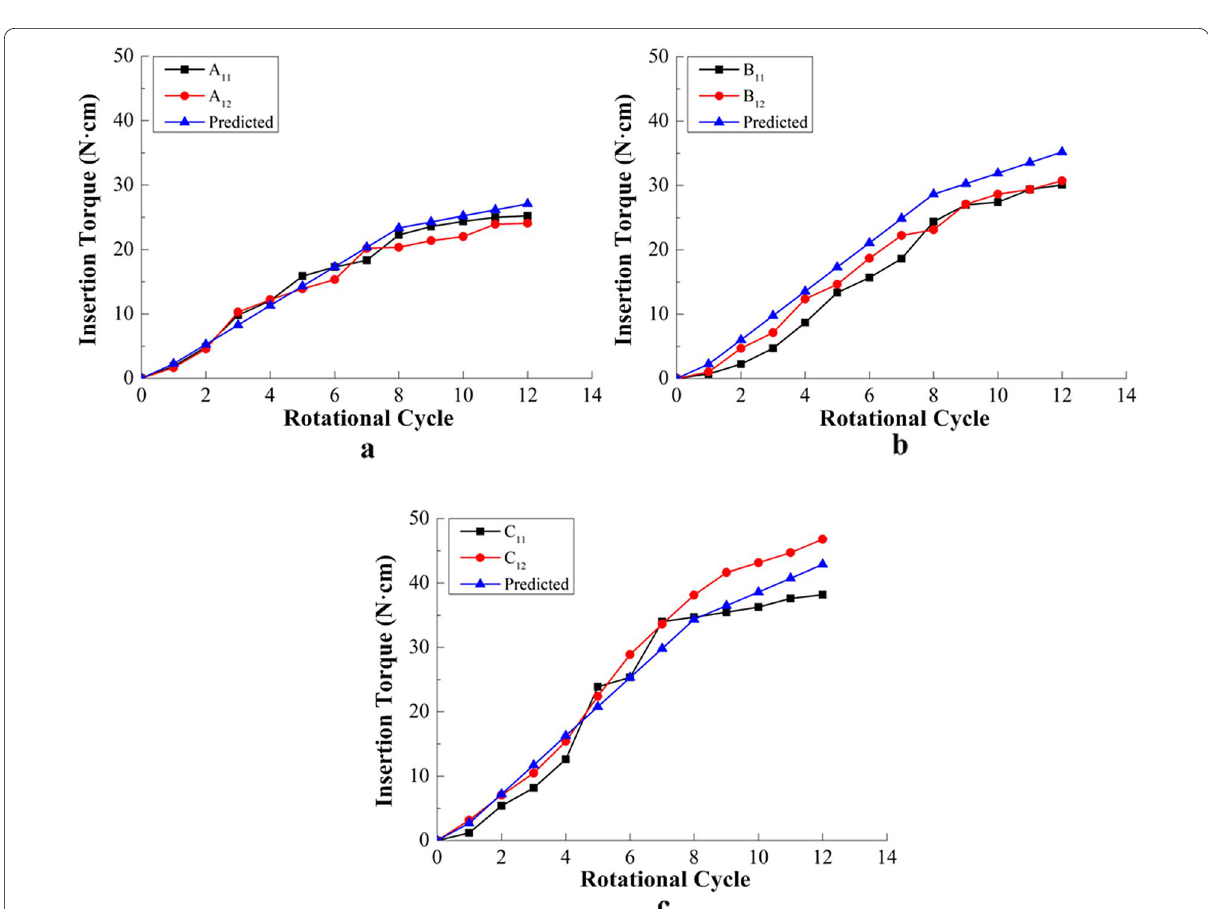
Figure 7 Insertion torques obtained by the mechanical model and experiments: a – c the results of three insertion tests, where A 11 , A 12 , B 11 , B 12 , C 11 , C 12 are the measured